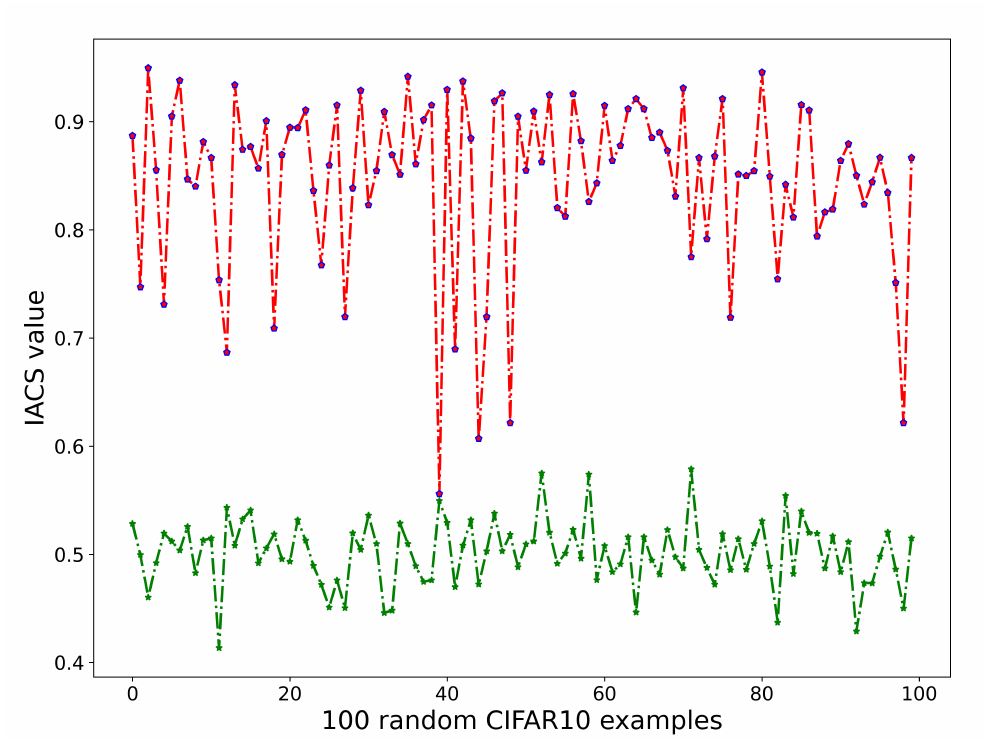
Figure 2. IACS comparison between normal and adversarial examples. The red points denote the normal examples’ IACS values, and the green points denote the adversarial examples’ IACS values.